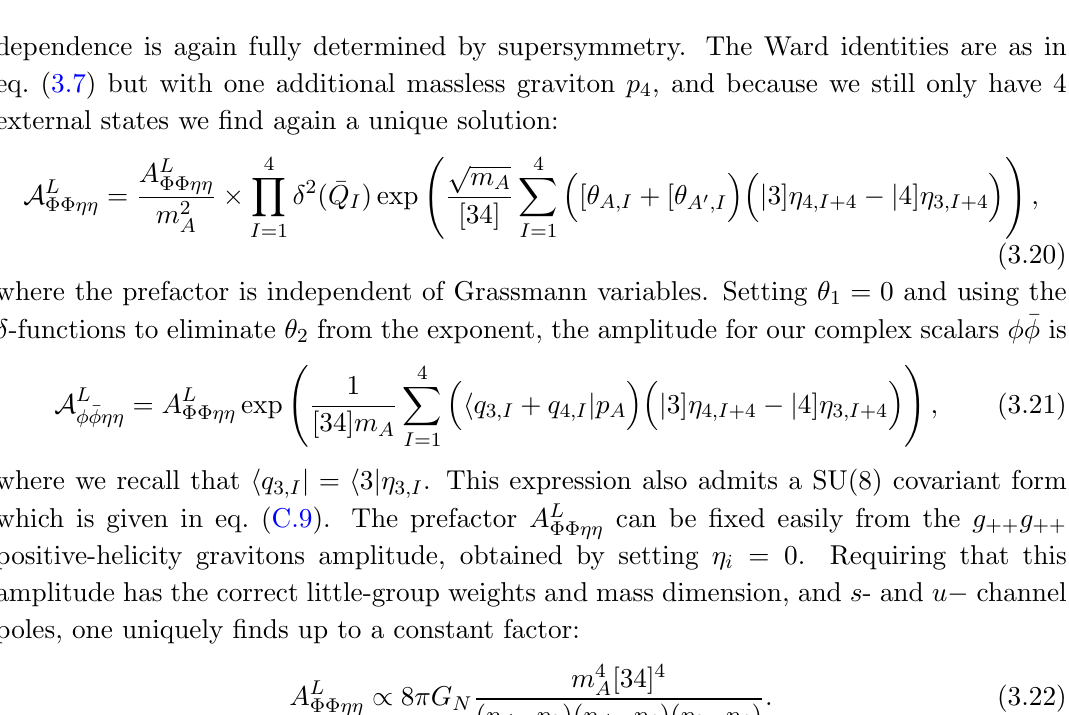
Figure 4 . 2 2 scattering of black holes, 1-loop →